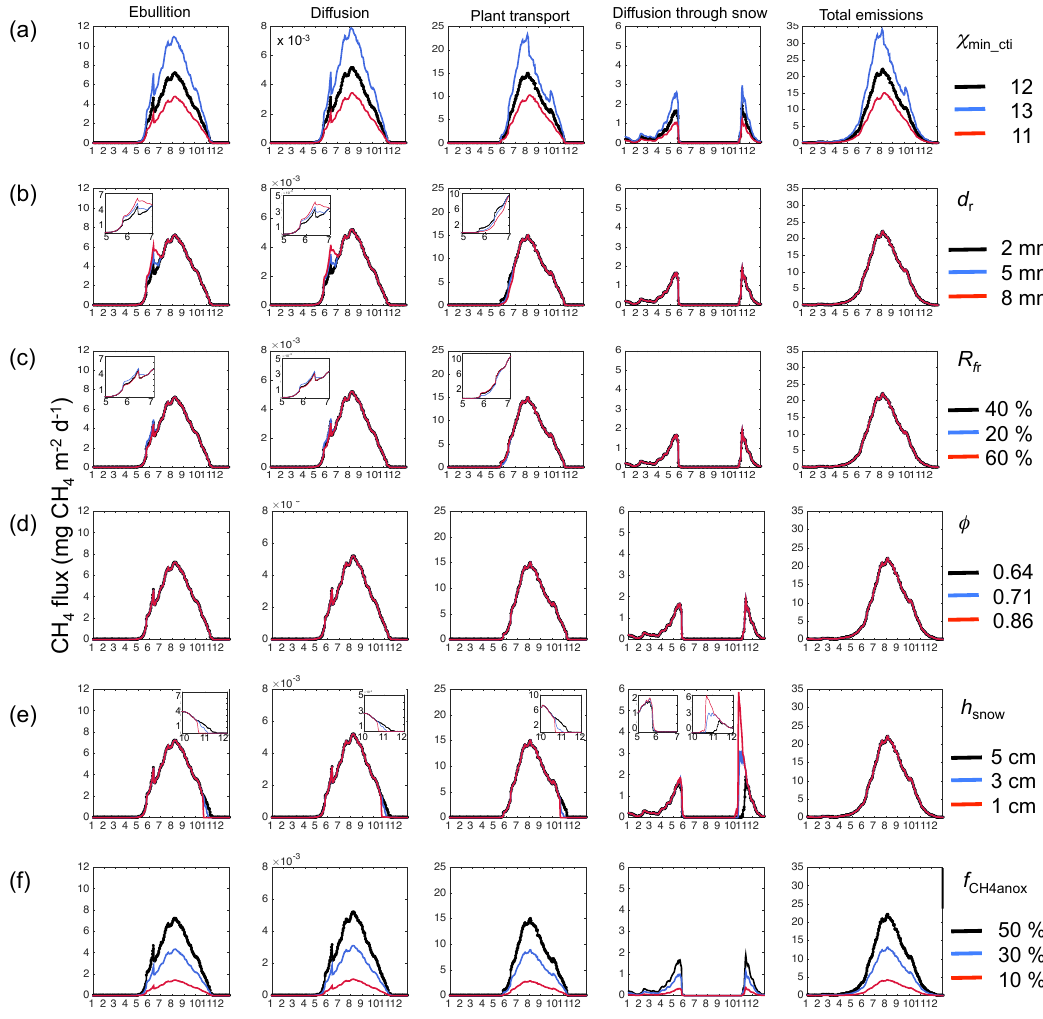
Figure 3. Results from the sensitivity experiments for the six selected parameters described in Table 2. Daily methane emissions for the individual transport pathways and total methane emissions are shown. The inset figures in some of the panels are zooms to periods of time where larger differences between signals are